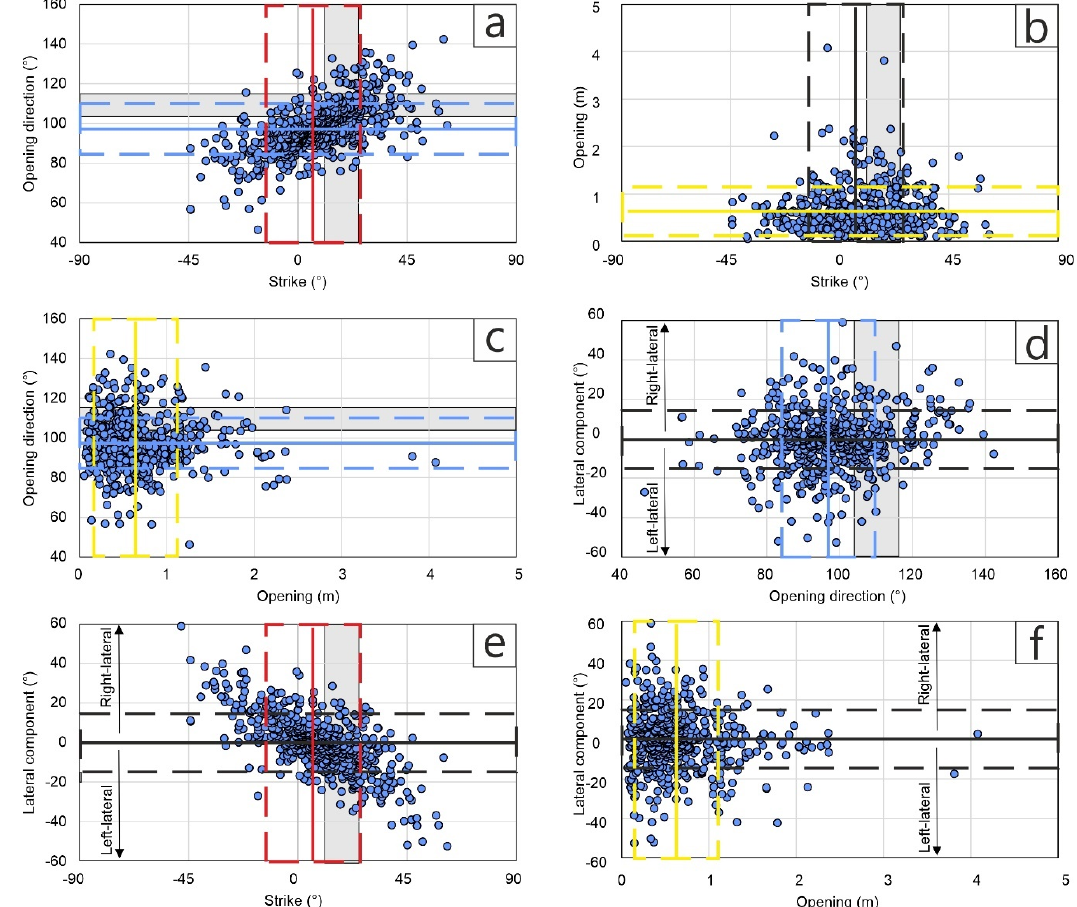
Figure 8. Graphs show ( a ) fracture azimuth vs. opening direction, ( b ) fracture azimuth vs. fracture dilation, ( c ) fracture dilation vs. opening direction, ( d ) opening direction vs. lateral component of movement, ( e ) fracture azimuth vs. lateral component of movement, and ( f ) fracture dilation vs. lateral component of movement. For all data, the mean value (continuous line) and the standard deviation range have been reported (dashed lines box), as well as the grey rectangle represents the expected range of values considering the spreading direction range (N104–115°).